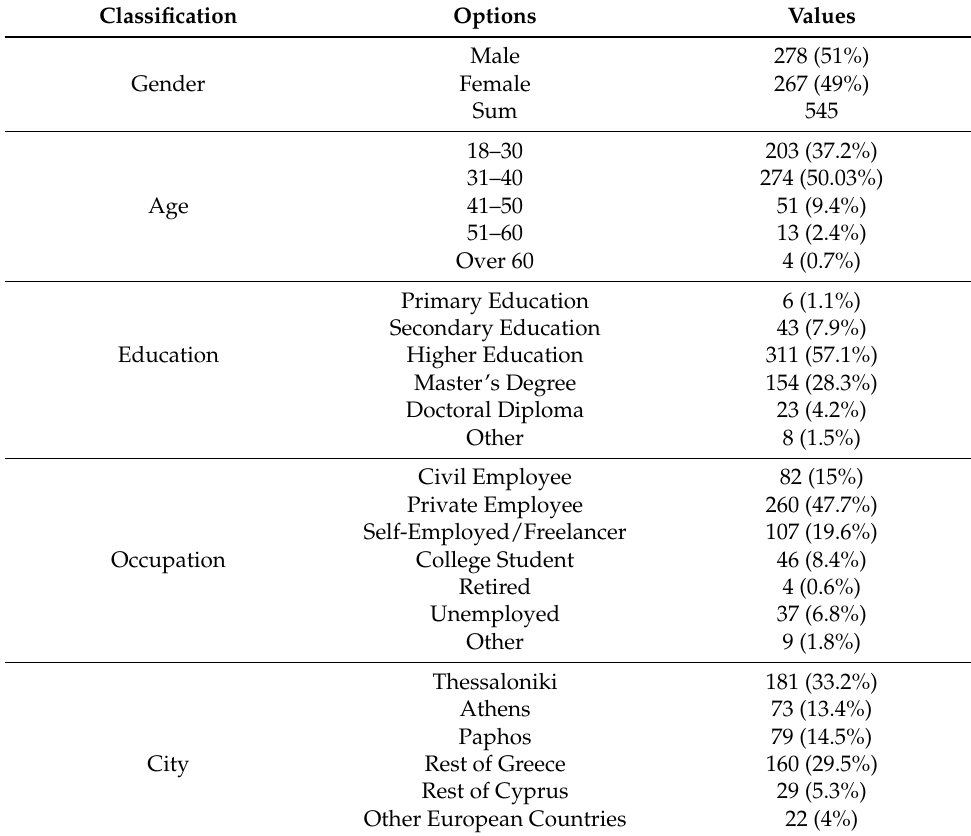
Table 1. Characteristics of